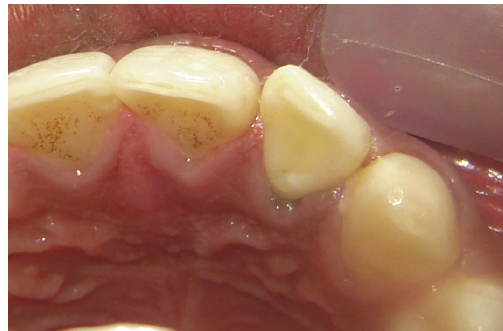
Figure 8: Palatal view immediately after restoration of maxillary right lateral incisor (mirror image).